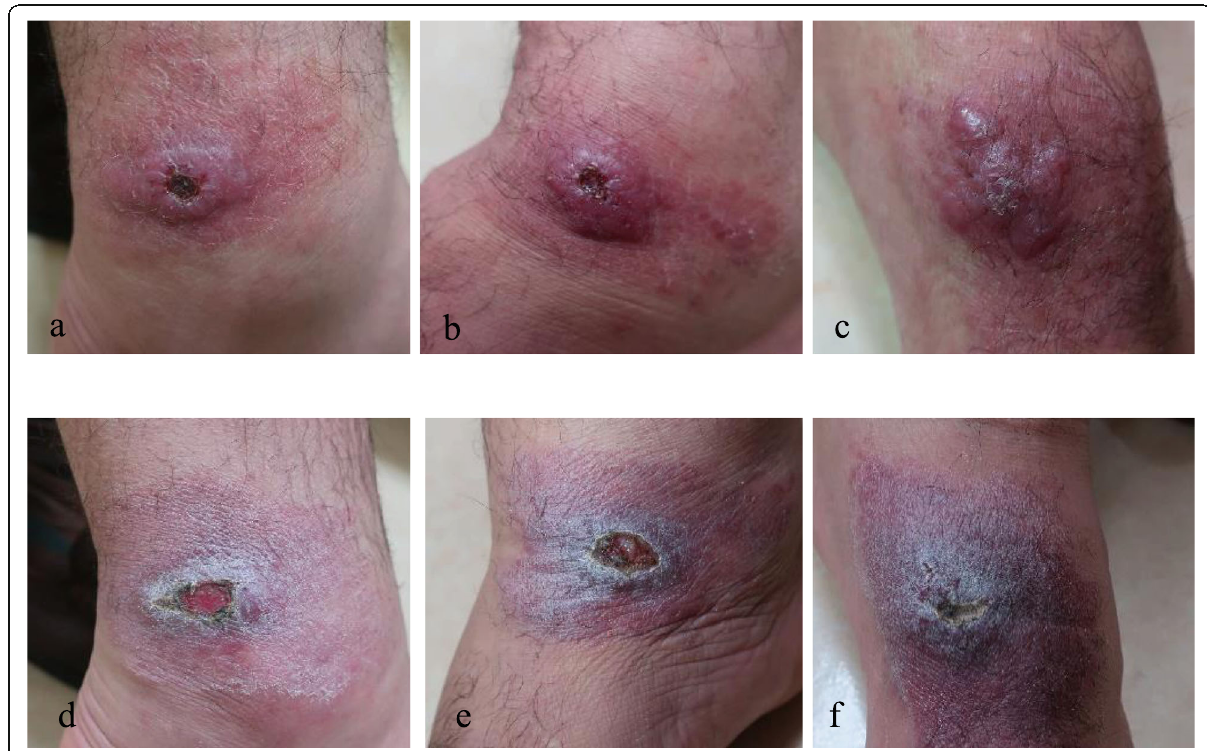
Fig. 1 Skin lesions at initial presentation ( a – c ) and after treatment ( d – f ). Erythematous nodules with peripheral ridges and central ulceration located on the right medial malleolus ( a ), right lateral malleolus ( b ), and the top of the left foot ( c ). After treatment, the erythema has disappeared and the nodules on the right medial malleolus ( d ), right lateral malleolus ( e ), and top of the left foot ( f ) have